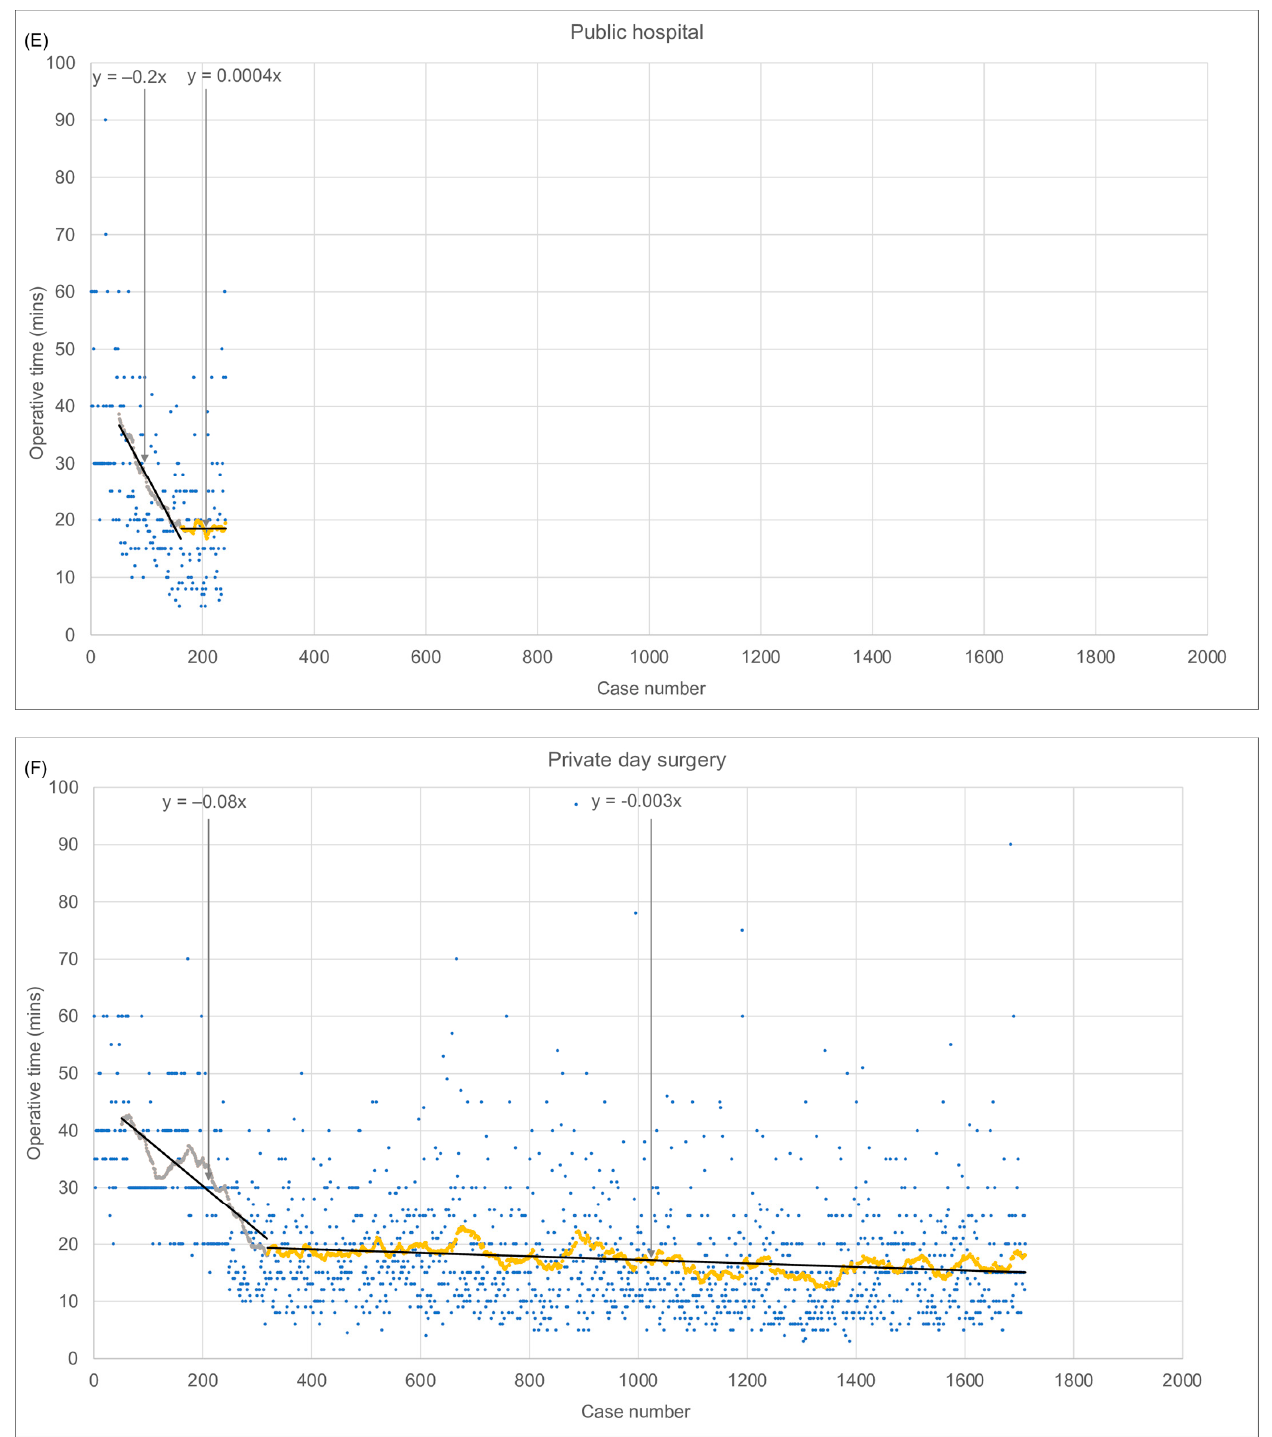
Figure 3. Rolling average operative time for ( A ) undersurface repairs, ( B ) bursal-sided repairs, ( C ) repairs utilising both techniques. Undersurface and bursal-sided repairs demonstrate a reduction in rolling average operative time between cases 0 and 200. ( D ) Rolling average operative time by surgeon caseload. Increased caseload showed a reduction in rolling average operative time. —Rolling average operative time for ( E ) public hospital cases and ( F ) private day surgery cases. Rolling average operative times reduced in both public and private hospitals, the private hospital was faster on average. Cases shown in blue, rolling average for 50 cases shown in grey, yellow orange, green and/or